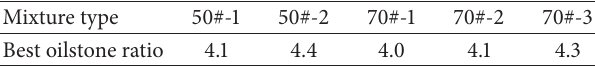
Table 1: The optimum asphalt